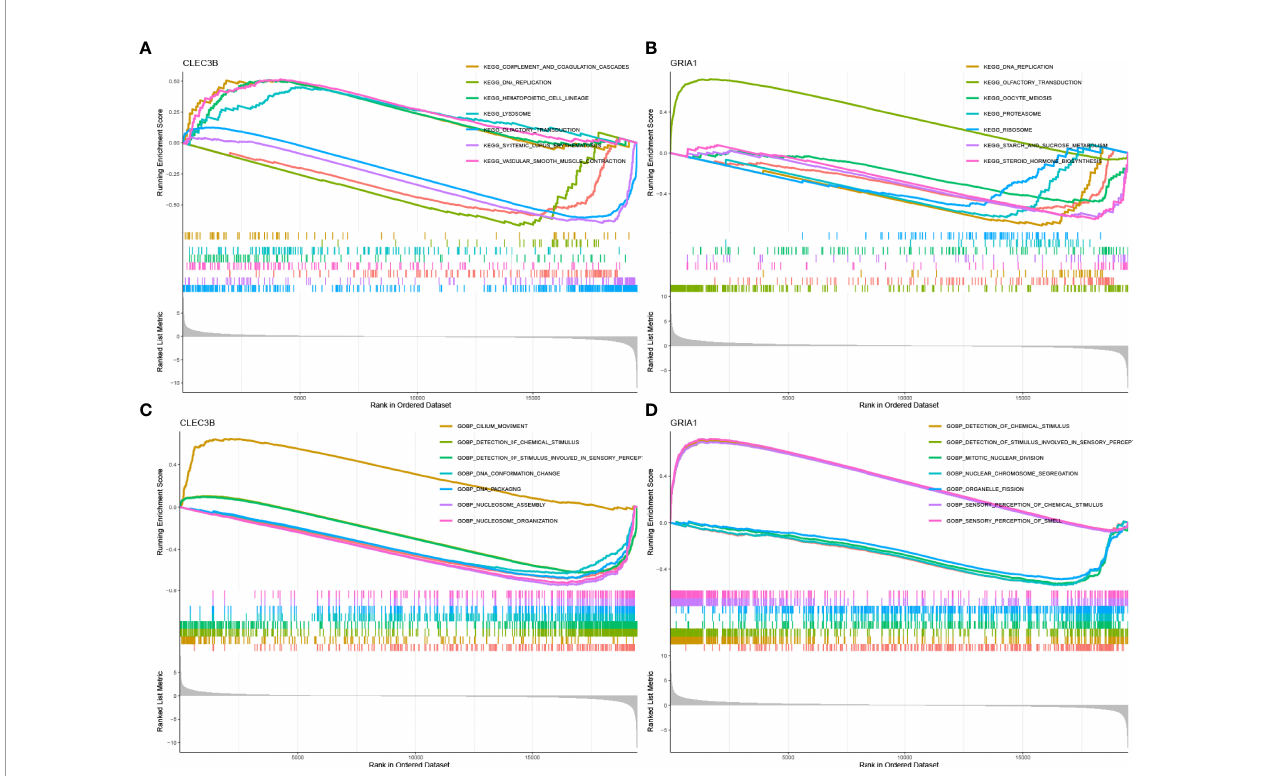
FIGURE 5 | GSEA of samples with high and low expressions of two hub genes. (A) Gene set of samples enriched in CLEC3B expression collected in KEGG. (B) Gene set of samples enriched in GRIA1 expression collected in KEGG. (C) Gene set of samples enriched in CLEC3B expression collected at GOBP. (D) Gene set of samples enriched in GRIA1 expression collected at